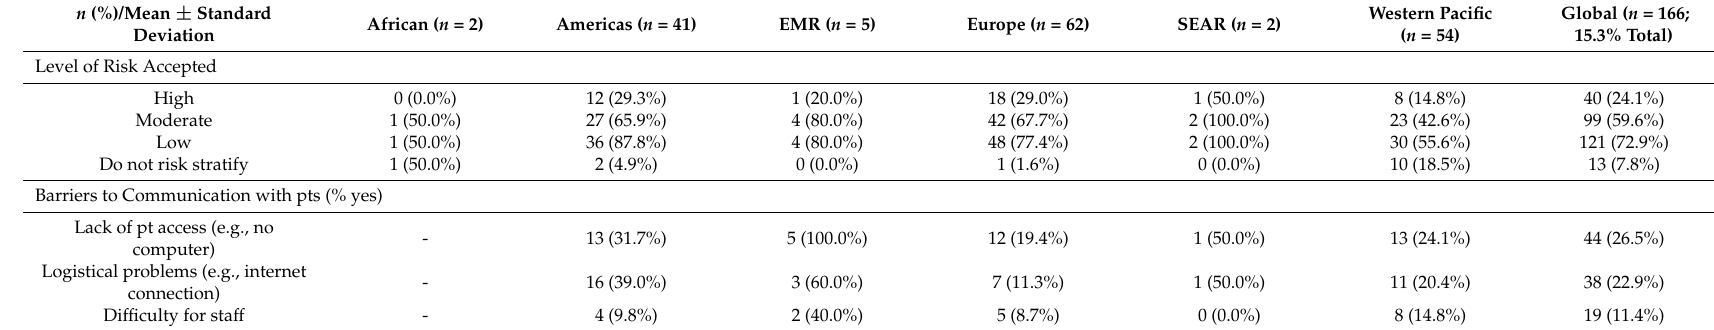
Table 1. Characteristics of Home-Based Programs by World Health Organization Region.